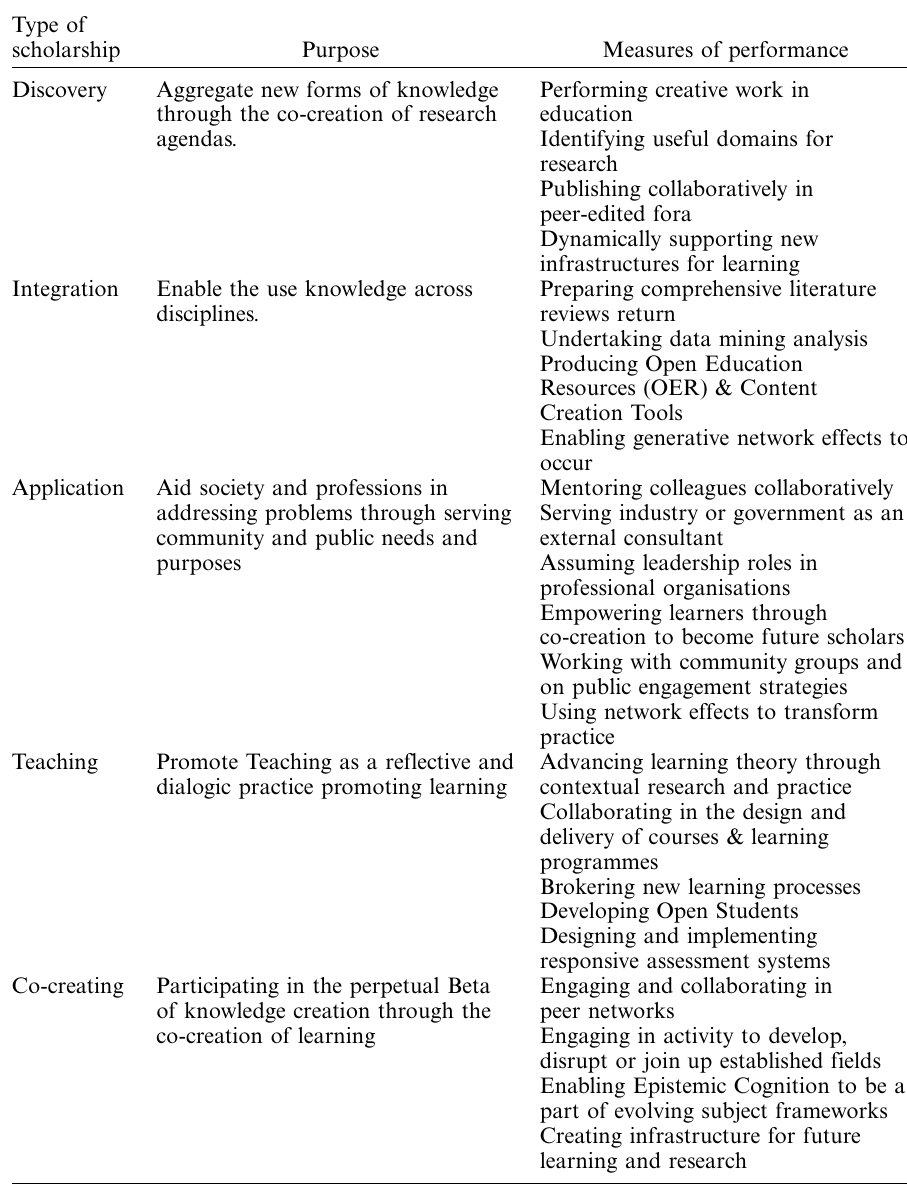
Table 2. Co-creation model of Open